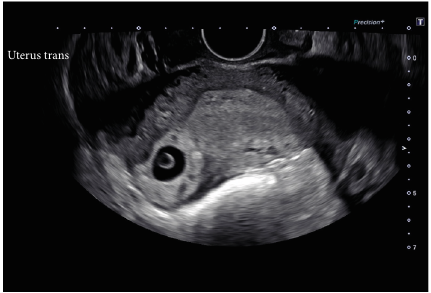
Figure 1: Ultrasound image of a right-sided cornual ectopic